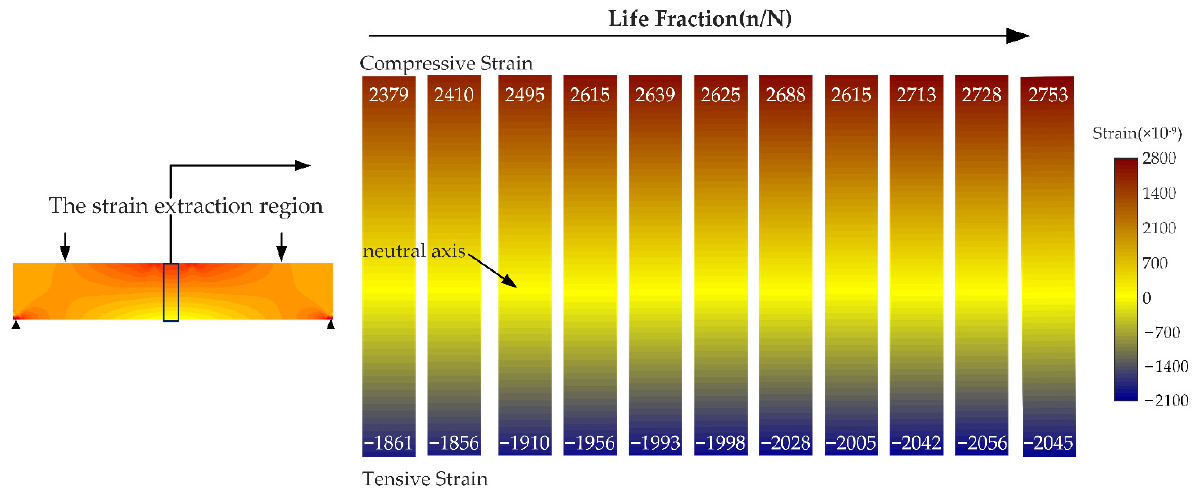
Figure 10. The four-point bending strain distribution.